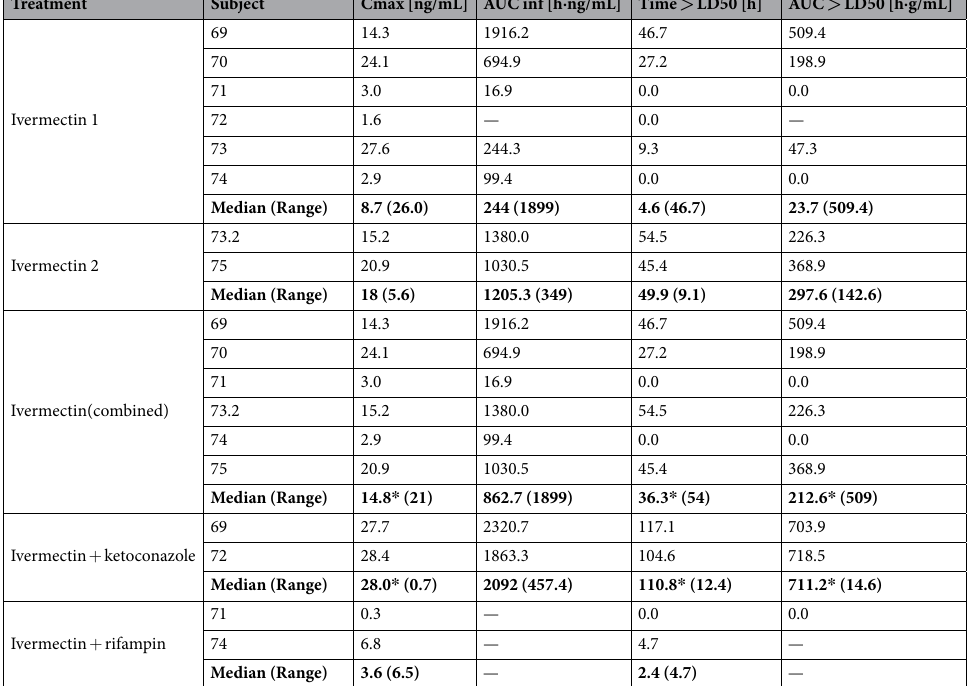
Table 1. Relevant PK parameters by treatment group. Footnote: Cmax: peak plasma concentration, AUC inf: area under the PK curve to infinity, LD50: the 10-day lethal concentration 50 of ivermectin for Anopheles gambiae (6 ng/ml). Pig 72 died and was replaced by pig 75. Pig 73 received ivermectin in phase 1 and was randomised to ivermectin alone in phase 2, this is denoted as 73/73.2, these observations were not combined in order to sustain sample independence. * Denotes a statistically significant